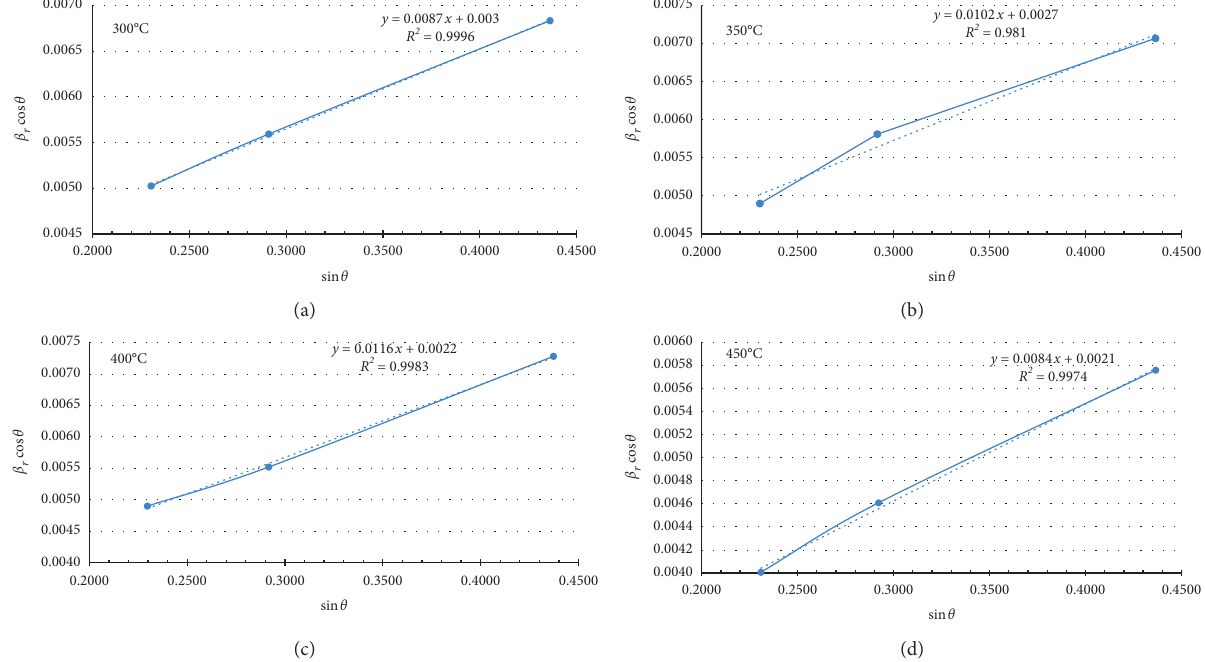
Figure 3: Plot of β r cos θ against sin θ of SnO 2 calcined at (a) 300 ° C, (b) 350 ° C, (c) 400 ° C, and (d) 450 ° C extracted from the XRD patterns. Table 1: Structural parameters of SnO � P42/mnm (136). 2 powder, lattice: tetragonal S.G. Calcine temp. ( °